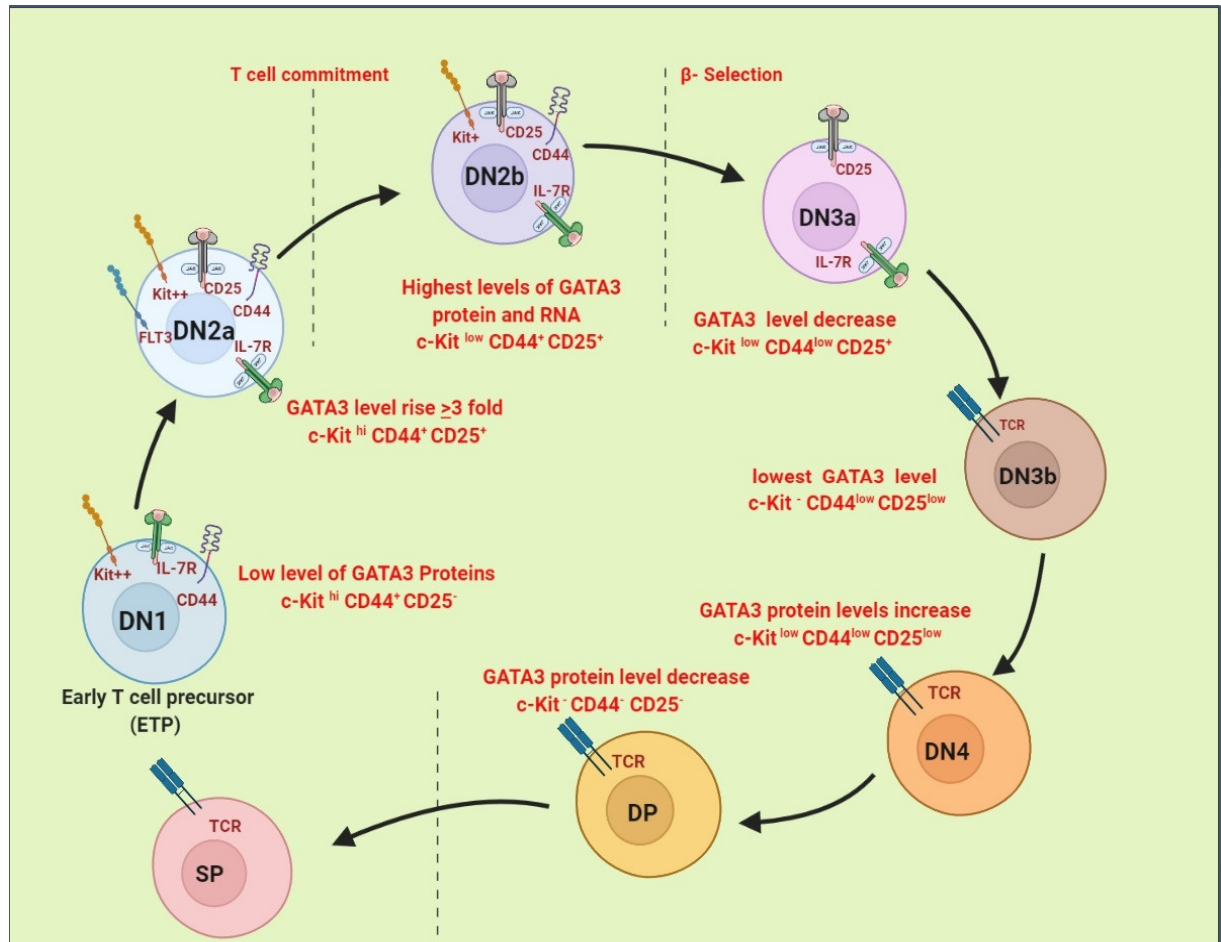
Figure 4. Expression of GATA3 during T cell development. Four-color intracellular detection of GATA3 in early DN thymocyte subsets from B6 adult mice they showed GATA 3 protein levels during T cell development besides defined subset expression of c-Kit, CD44, and CD25.